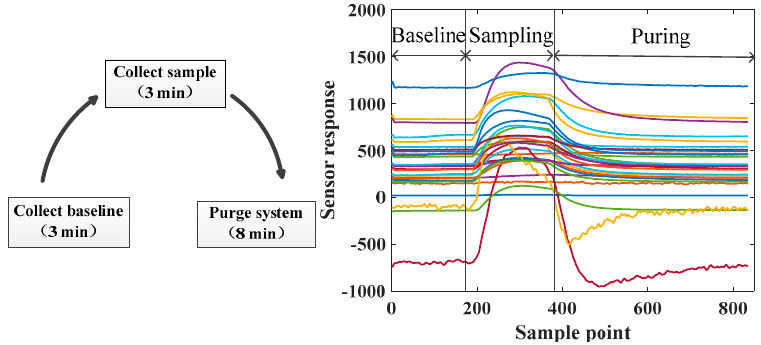
Figure 3. Illustration of sampling process and corresponding sensor response cycle.